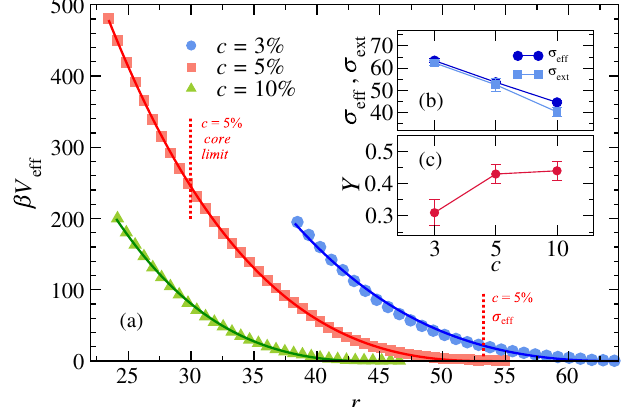
FIG. 2. Effective potentials for microgels at the liquid-liquid interface and related 2D Hertzian fit parameters. (a) Numerical results refer to three values of the cross-linker concentrations c : 3% (circles), 5% (squares), and 10% (triangles). Full lines are fits to numerical results using Eq. (1). The two vertical dotted lines ≈ 53 σ indicate the value σ m and the distance at which the cores eff of the two microgels get in contact ( r ≈ 30 σ m ) for c ¼ 5% ; (b) Microgel effective diameter σ compared to the extension on eff the plane of the interface σ calculated as in Ref. [29], in units of ext σ ’ s modulus Y extracted from the 2D Hertzian fit to m ; (c) Young k T= σ 2 V m H in units of B